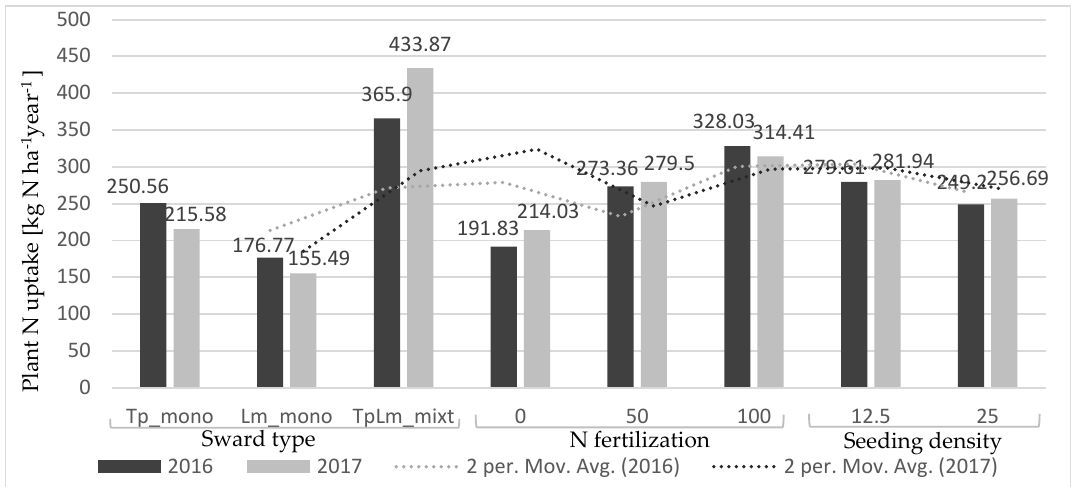
Figure 1. N uptake in monoculture and mixture.